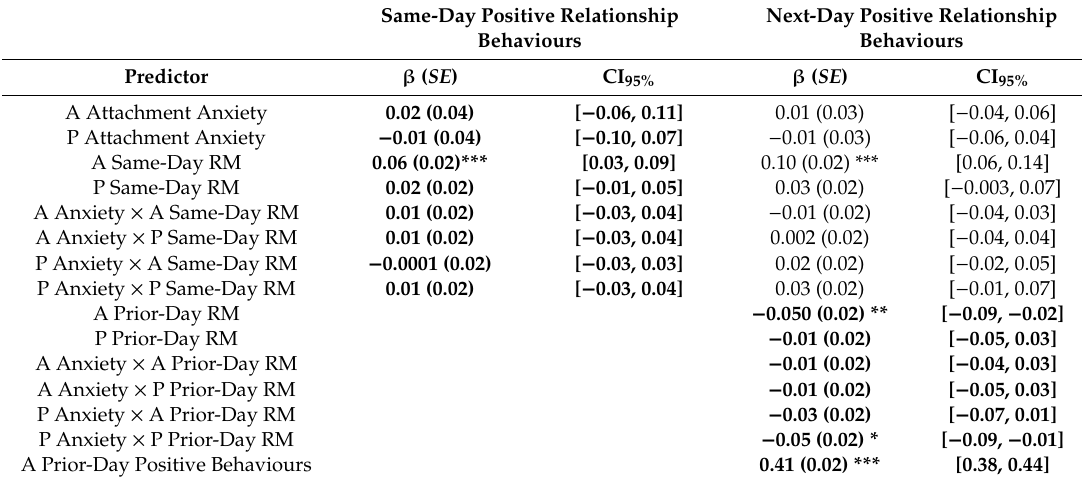
Table 3. Associations of attachment anxiety and daily relationship mindfulness with same-day and next-day positive relationship